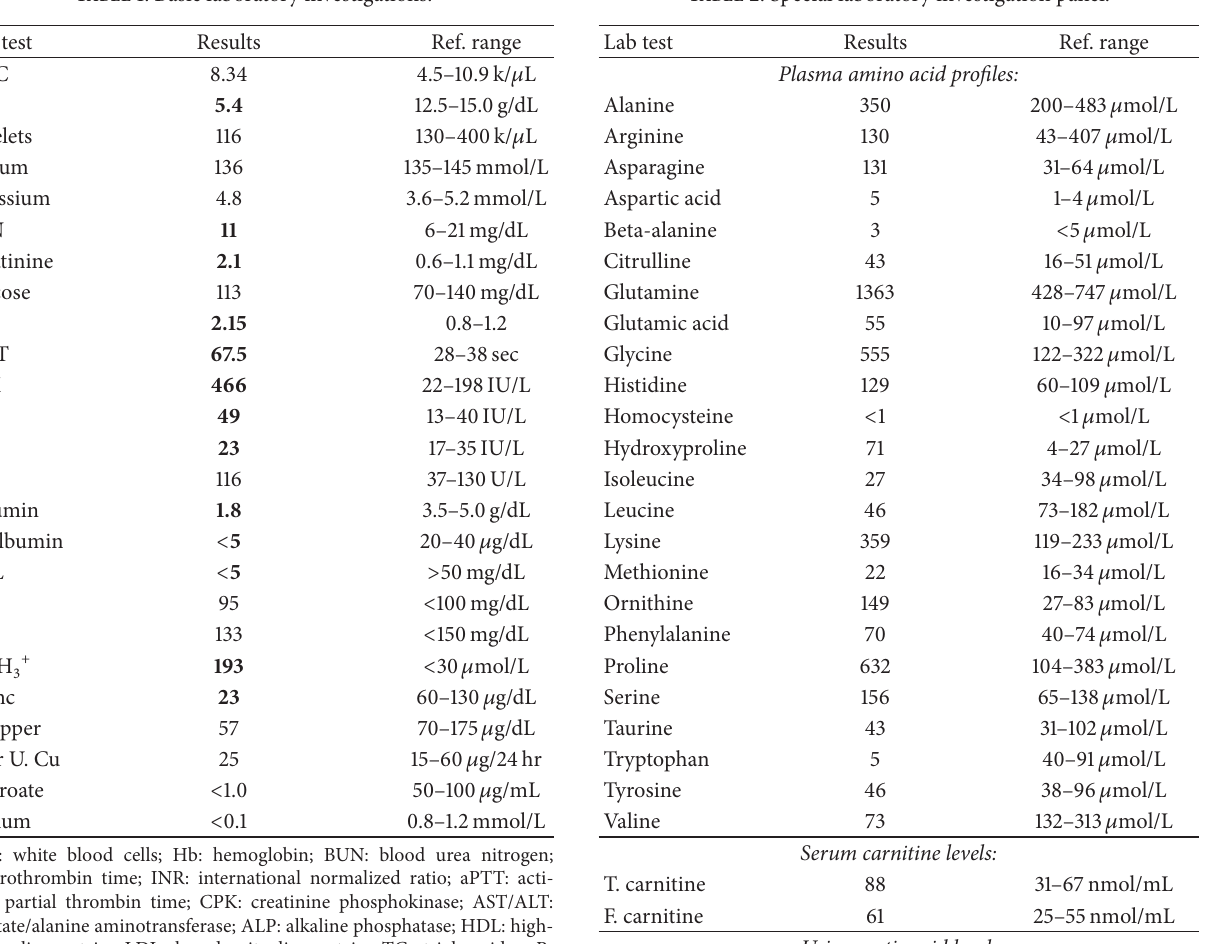
Table 1: Basic laboratory investigations. Table 2: Special laboratory investigation